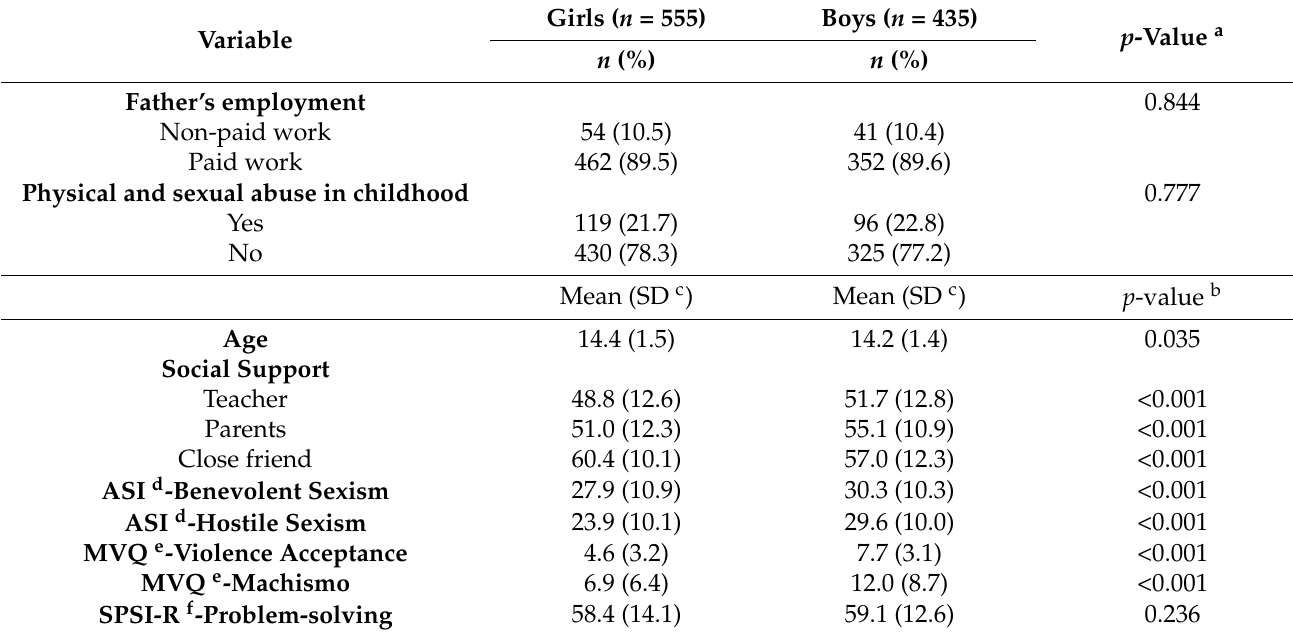
Table 1. Main Characteristics of the Baseline Sample of the Lights4Violence Project from Alicante, Spain ( n = 255), Rome, Italy ( n = 285), Iasi, Romania ( n = 343), Matosinhos, Portugal ( n = 259), Poznan, Poland ( n = 190) and Cardiff, UK ( n = 204), 2018–2019.